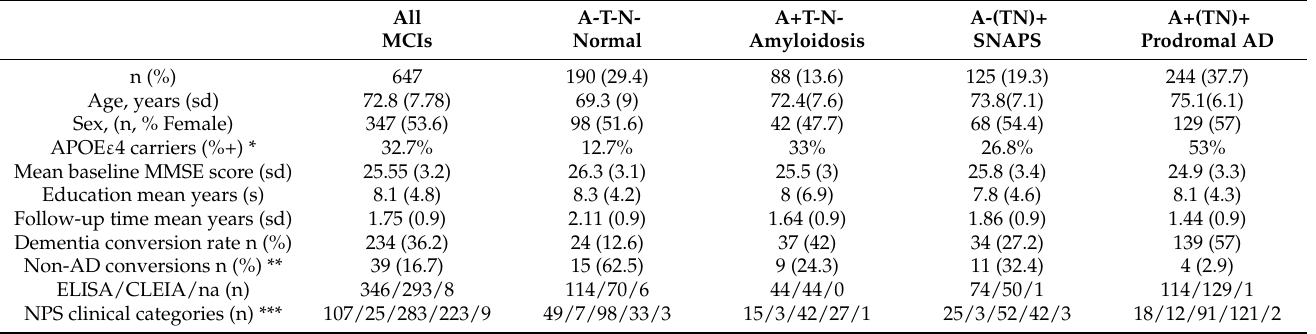
Figure 3. MCI to dementia progression analysis in ACE Alzheimer Center Barcelona CSF cohort. (Panel ( A )). Kaplan-Meier survival analysis. (Panel ( B )). Conversion rate observed in AT(N) categories. (Panel ( C )). AT(N) categories included in each stratum. Abbreviations: MCI, CSF. Table 4. MCI longitudinal study: demographics, clinical, genetic, and neuropsychological